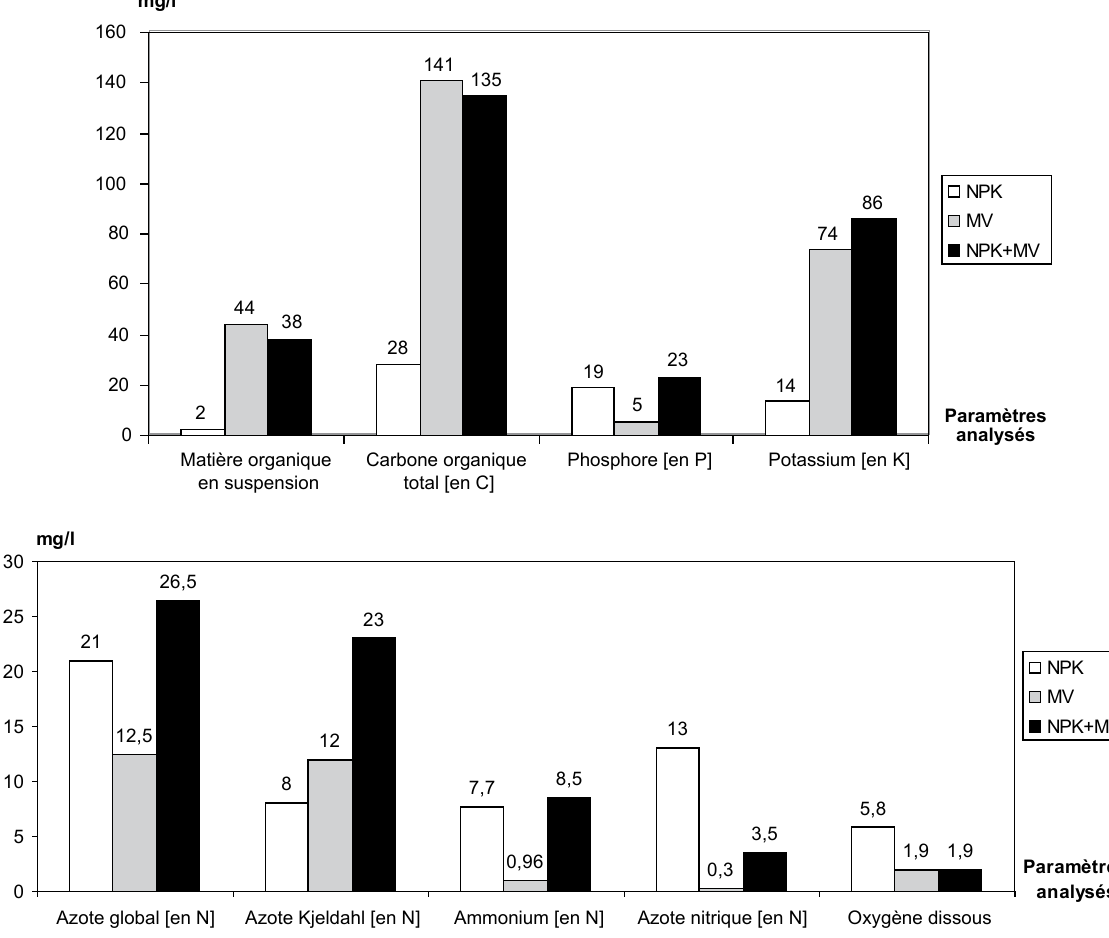
, J , J , J et J ). 0 2 9 16 23